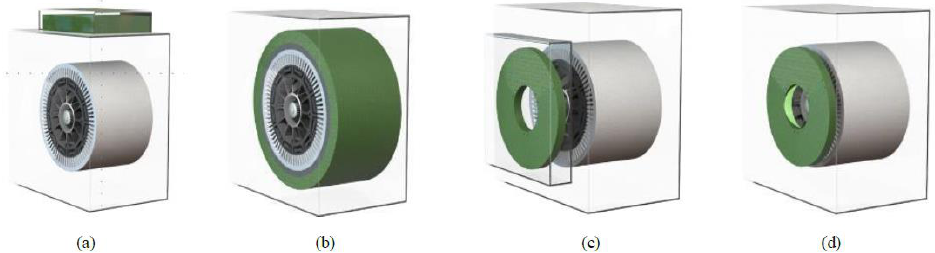
Figure 9. Motor and inverter integration options [26] ( a ) radial housing mount; ( b ) radial stator mount; ( c ) axial endplate mount; ( d ) axial stator mount.